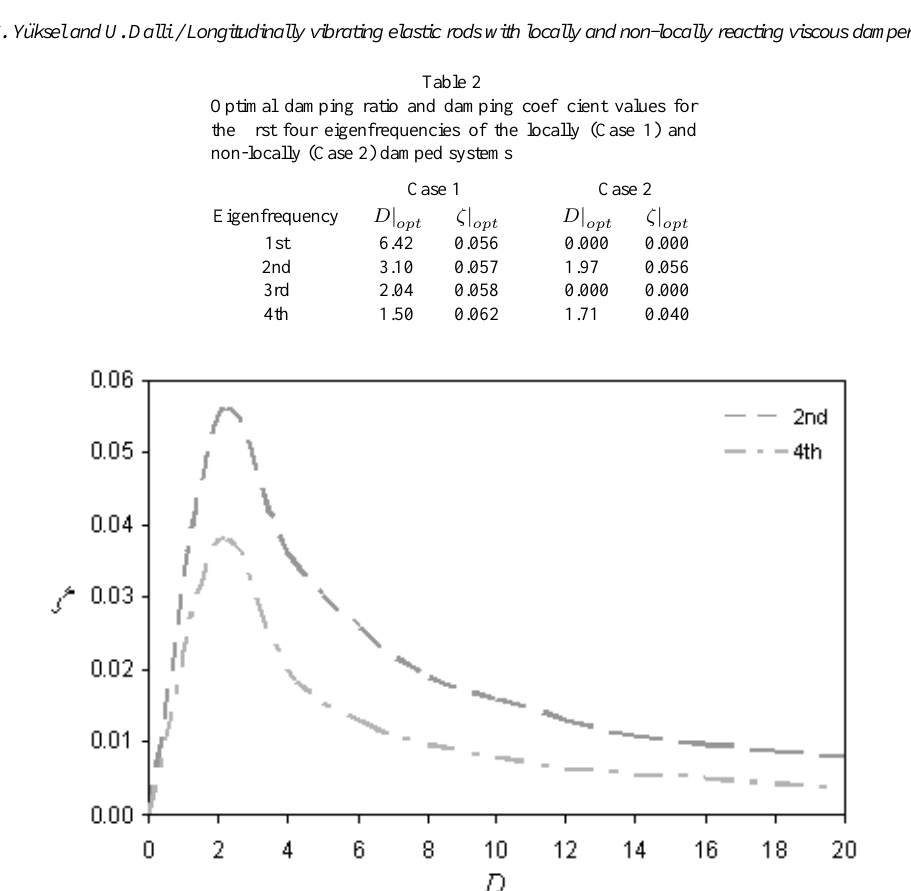
Fig. 6. Damping ratios versus dimensionless damping coefficient for the first four eigenfrequencies of non-locally reacting damping for a = 0.05. For the non-locally reacting damping case, Fig. 3 shows similar damping ratio versus damper location plots for the 2nd and 4th eigenfrequencies as in Fig. 2. However, for the 1st and 3rd eigenfrequencies of the non-locally damped case, the damping ratio approaches zero regardless of the damper location. Such a result is obvious since the real parts of the 1st and 3rd eigenfrequencies listed in Table 1 for Case 2 are all zero. This situation can be